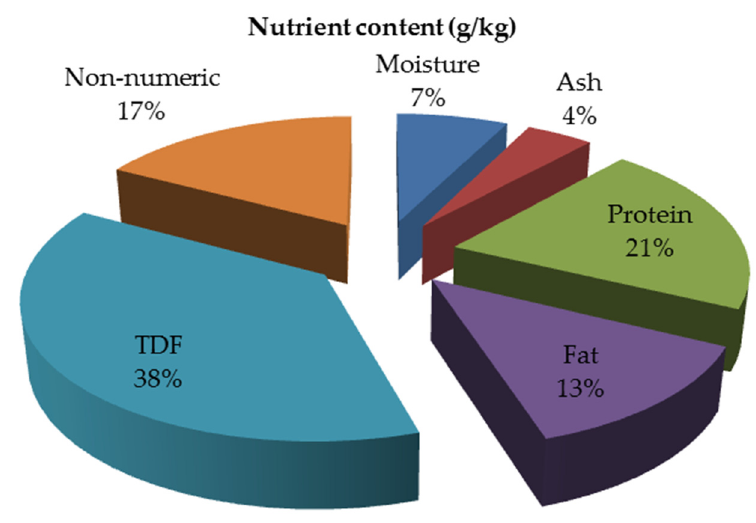
Figure 2. Nutrient content of dried TP (g/kg). Table 2. The antioxidant content of tomato pomace (g/kg dry matter basis).